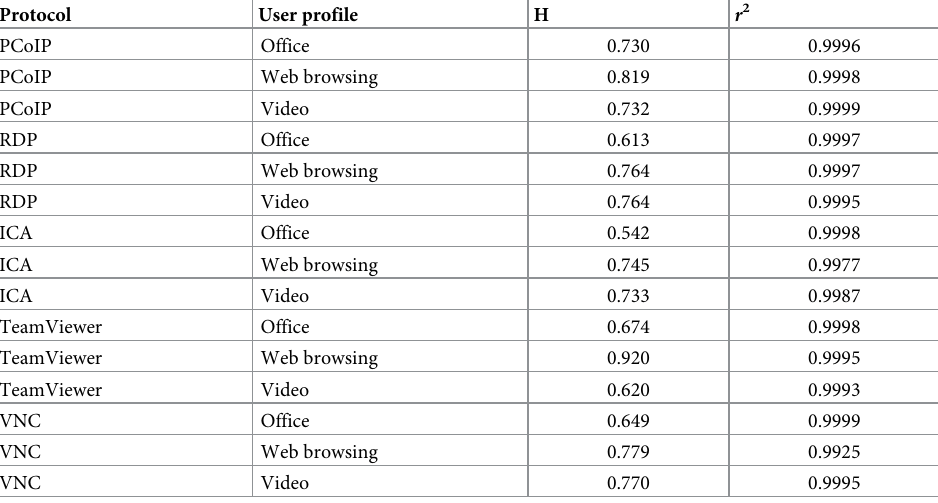
Table 6. Estimation of Hurst parameter for aggregation of 90 users.